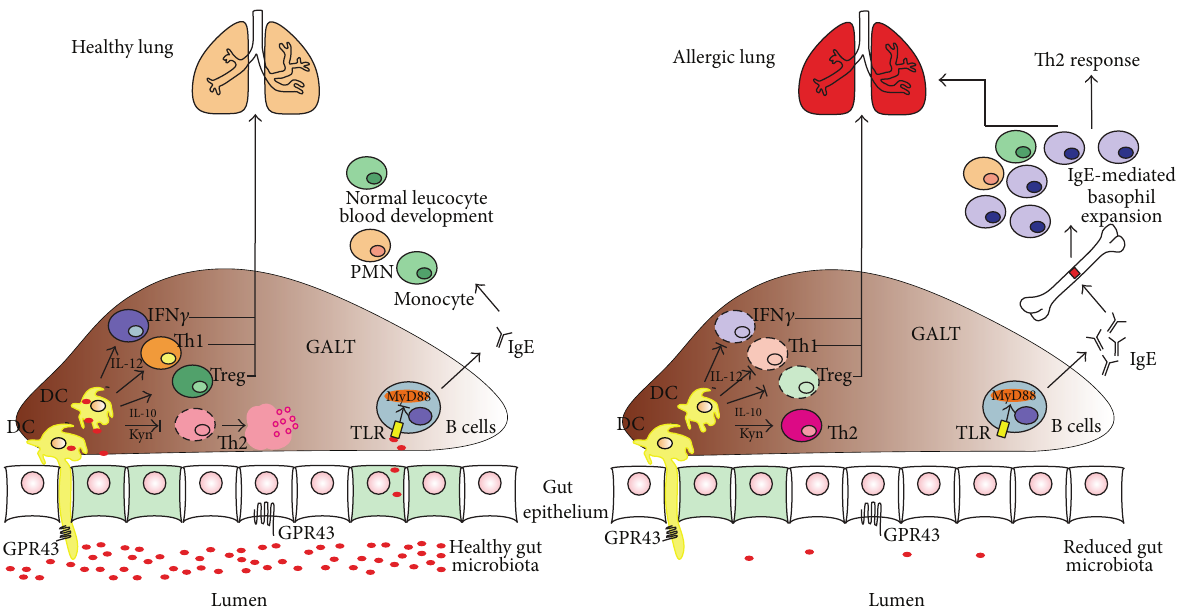
Figure 1: Schematic representation of the pulmonary allergic response induced by gastrointestinal (GI) immune cells and two microbiota- related conditions (a healthy gut microbiota and a reduced gut microbiota following antibiotic treatment). Microbes in the intestines are sampled by Toll-like receptors (TLRs) on DCs either directly in the lumen or in the gut-associated lymphoid tissue (GALT). In the healthy gut microbiota, polymorphonuclear development (PMN) is normal and DCs become regulatory DCs (DCr) that promote development of Tregs and/or Th1 cells and natural killer (NK) cells. These NK cells inhibit Th2 inflammation. Antibiotic treatment kills a large proportion of healthy microbiota, leading to a reduced gut microbiota and an inflammatory environment without DCs, Th1 cells or NK cells. In this environment, an unhealthy microbiota elevates serum immunoglobulin E (IgE) levels, increases circulating basophil populations, and exacerbates basophil- mediated Th2 responses (adapted from Forsythe